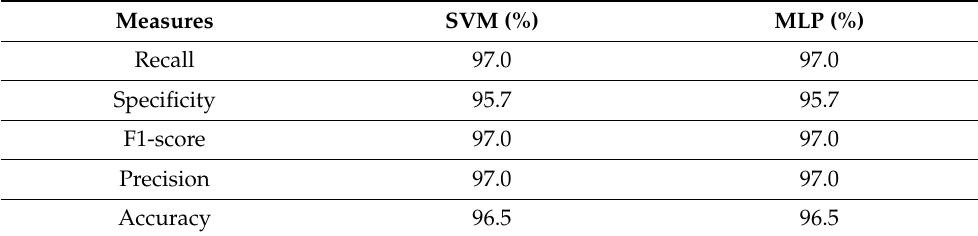
Table 5. Performance assessment for proposed classifiers without